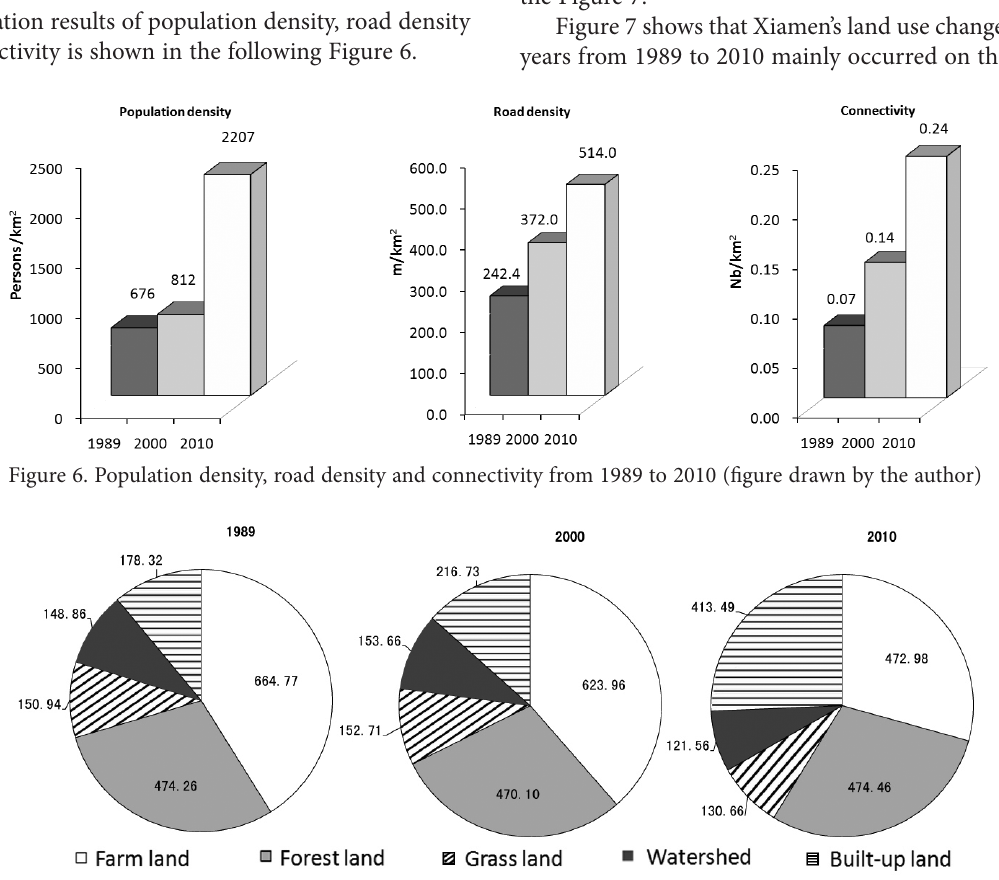
Figure 7. Land use mix in Xiamen City from 1989 to 2010 (km 2 , figure drawn by the